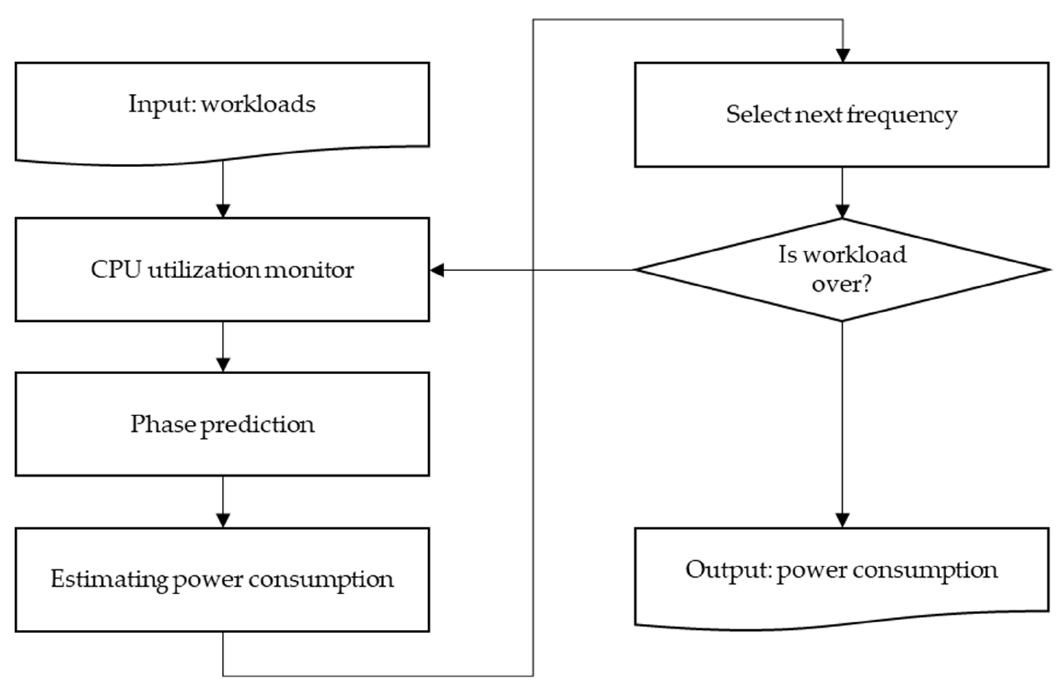
Figure 5. Overall flow of the proposed DVFS method.